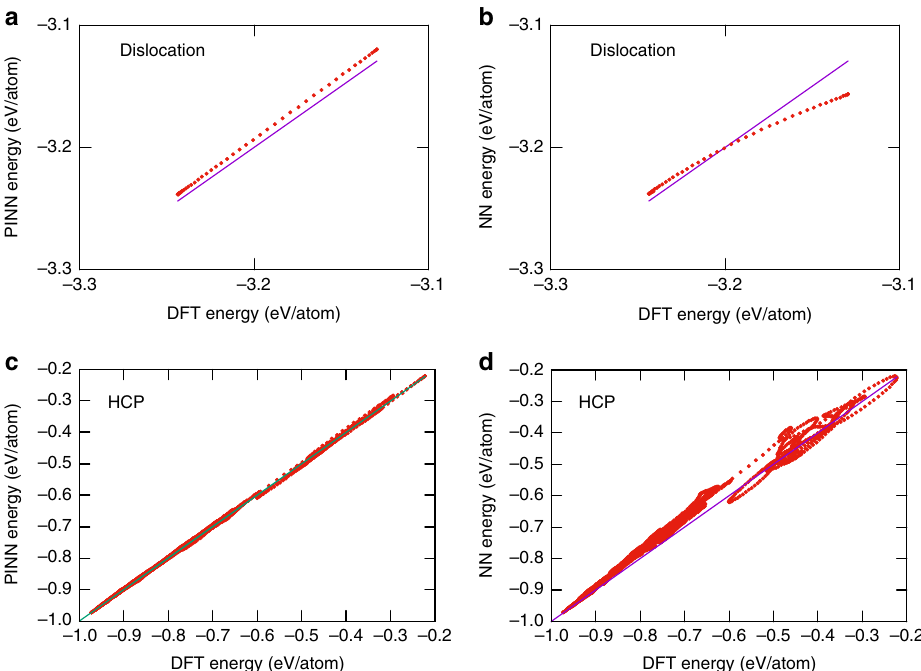
Fig. 4 Testing of the NN and PINN potentials. a , b Energy of an edge dislocation in Al in NVE MD simulations starting at 700 K. c , d Energy of HCP Al in NVT MD simulations at 1000, 1500, 2000, and 4000 K. The energies predicted by the PINN ( a , c ) and NN ( b , d ) potentials are compared with DFT calculations from 20,21 . The straight lines represent the perfect fi t